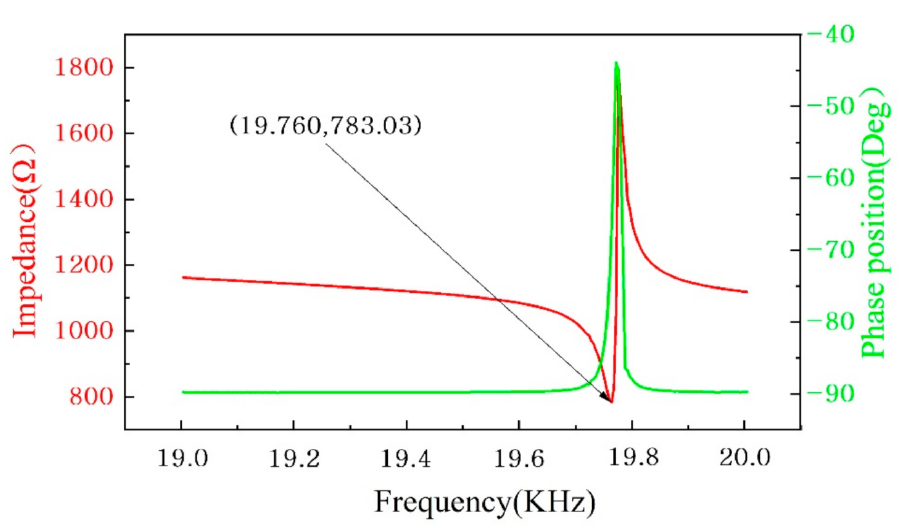
Figure 4. Impedance test of the ultrasonic vibration